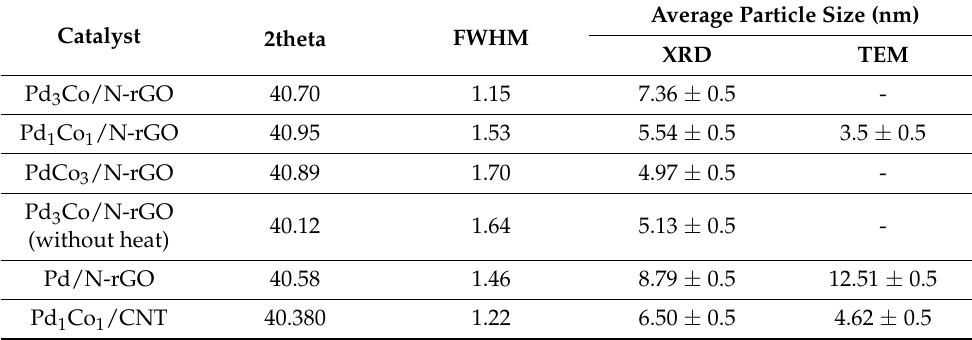
Table 1. XRD and TEM analyses of the as-prepared catalysts.